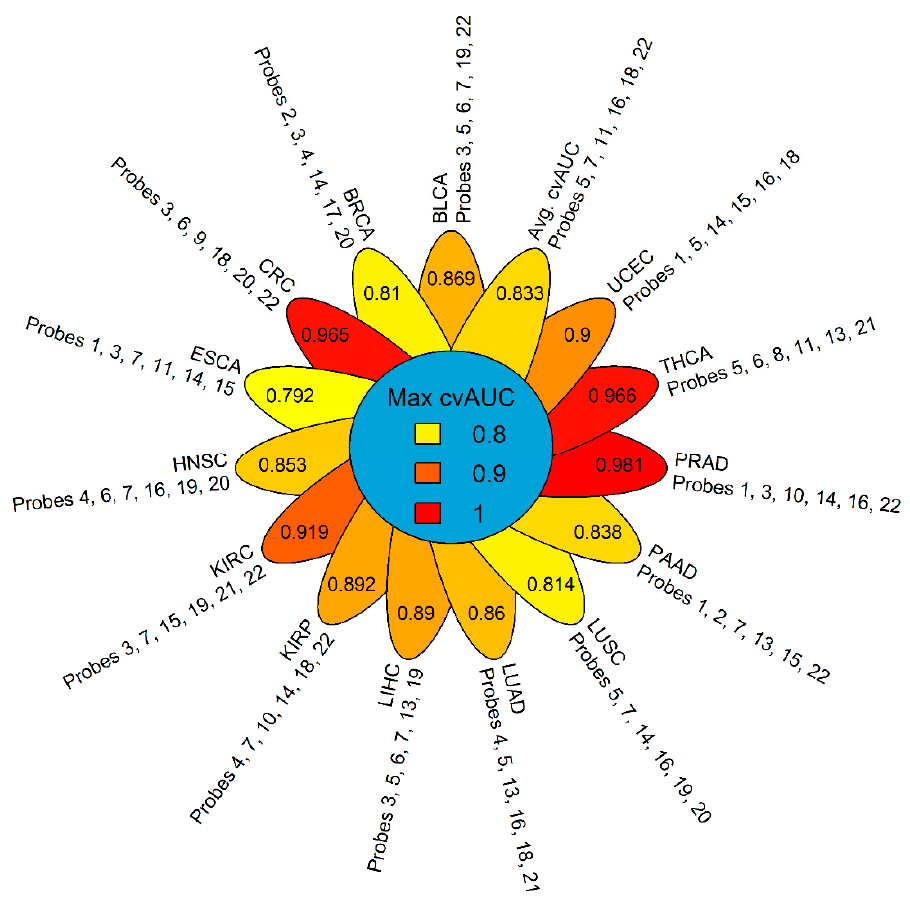
Figure 8. Flower plot of the maximum calculated cross-validated AUC for classifying each of the 14 tumors against all others, along with the corresponding probe combination that yielded the displayed AUC. Please refer to Table 1 for tumor dataset abbreviations.